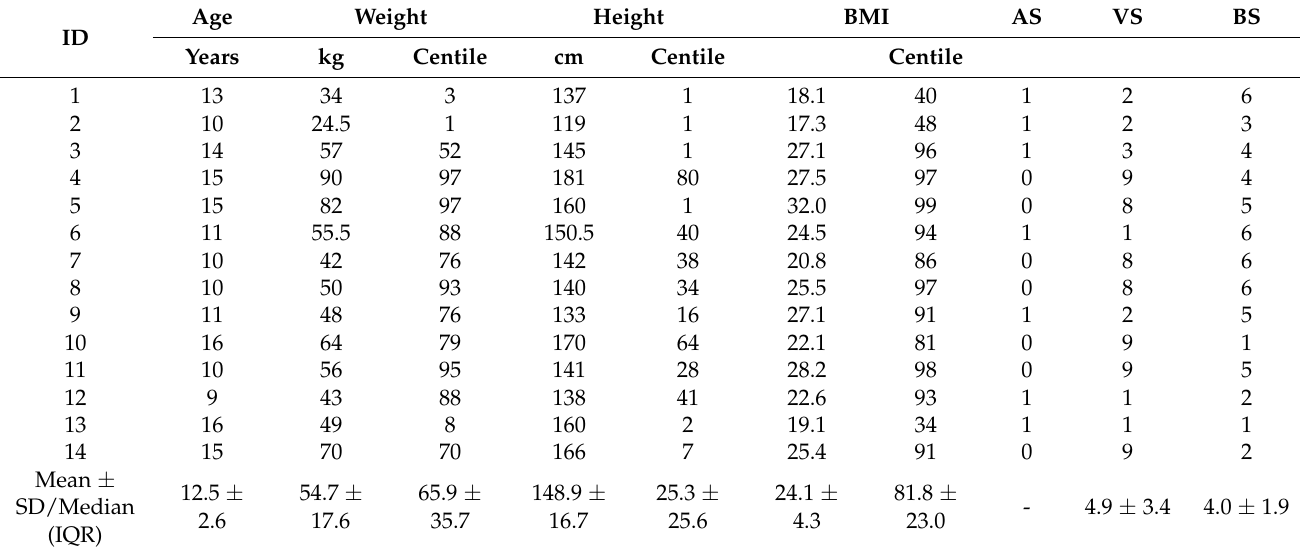
Table 1. Anthropometric characteristics of patients.